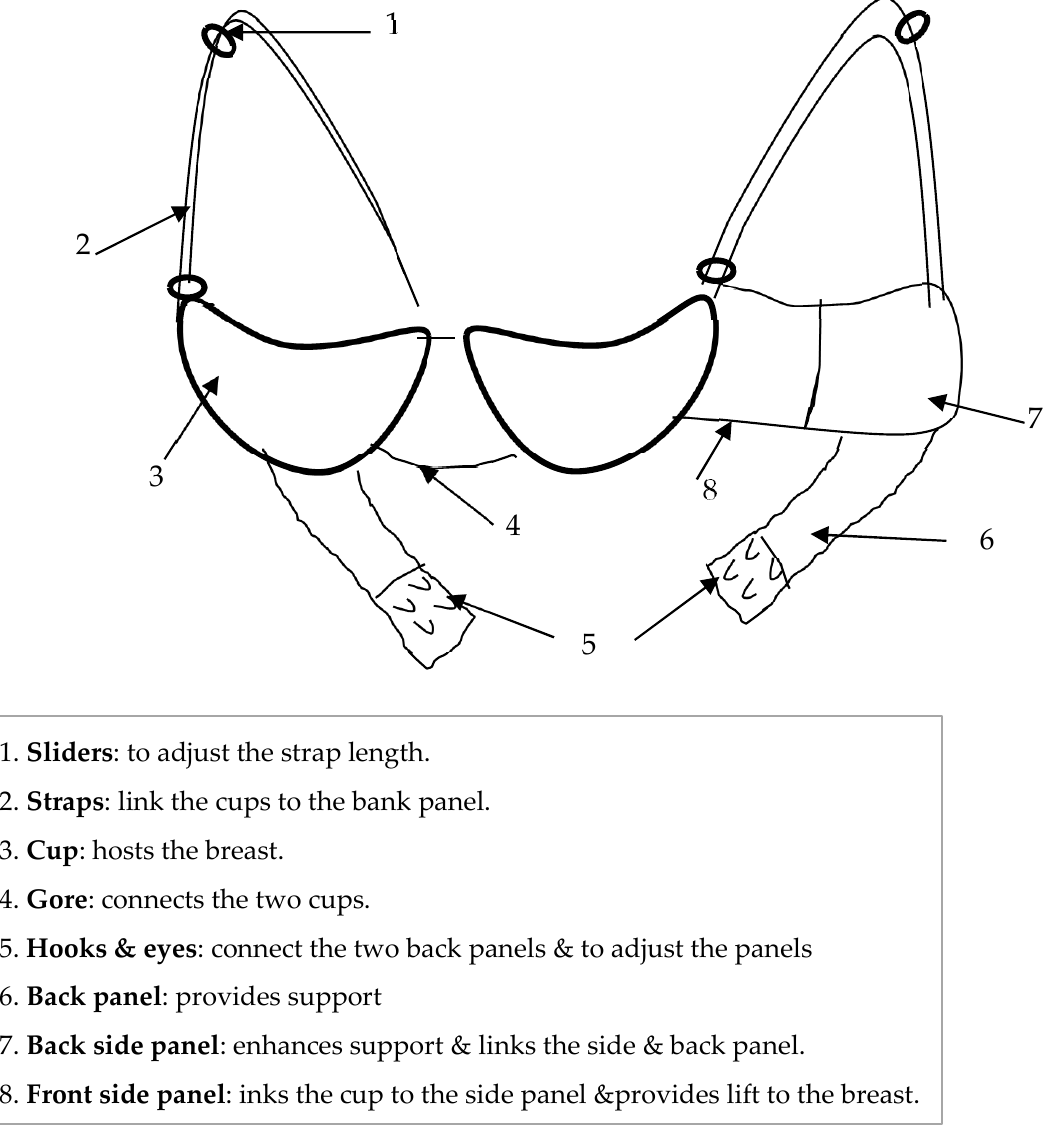
Figure 2. Front view of a typical bra.